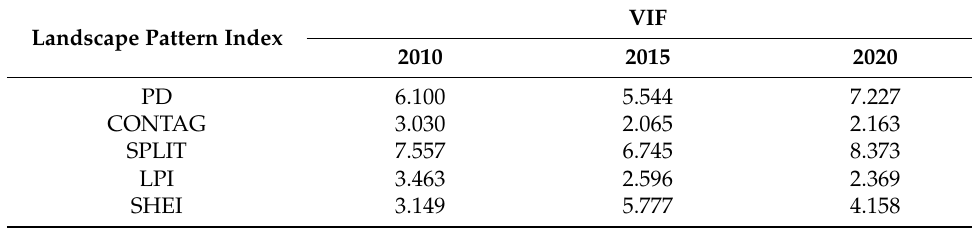
Table 6. Multicollinearity diagnosis (dependent variable: ESV).